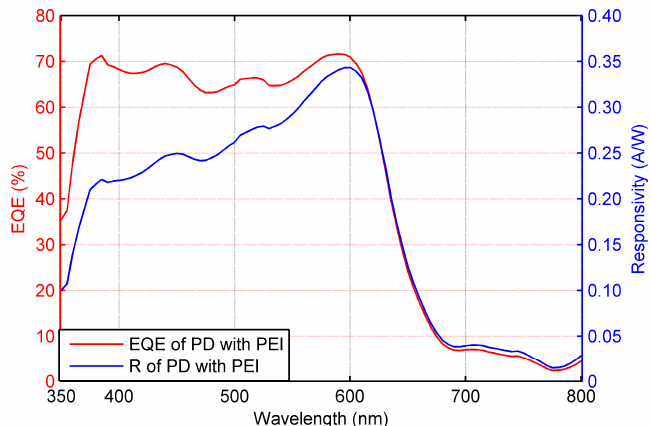
Figure 7. External Quantum Efficiency (EQE) of the OPD fabricated with the PEI interlayer. In the visible range, peak EQE of 70% and responsivity up to 0.34 A/W are achieved, comparable to similar OPDs with evaporated cathode.